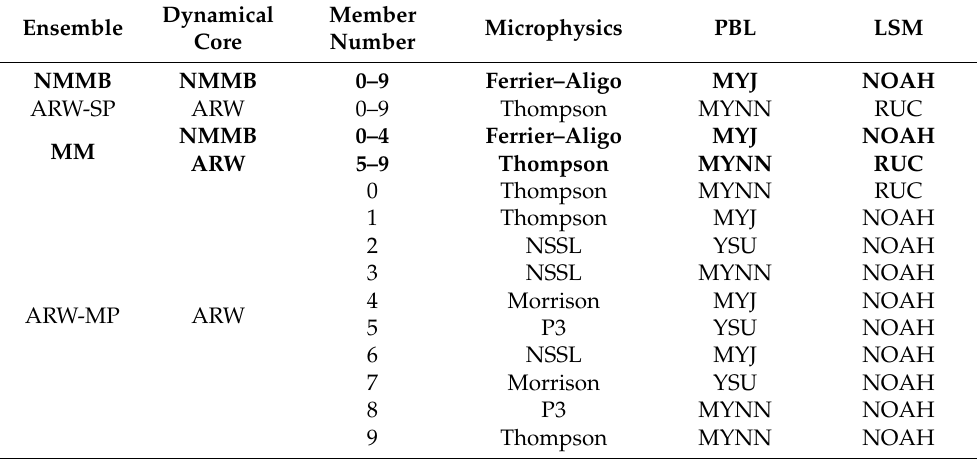
Table 3. Ensemble-to-ensemble comparisons. Ensemble Comparison Description Comparing how model and scheme choices impact storm mode and morphology